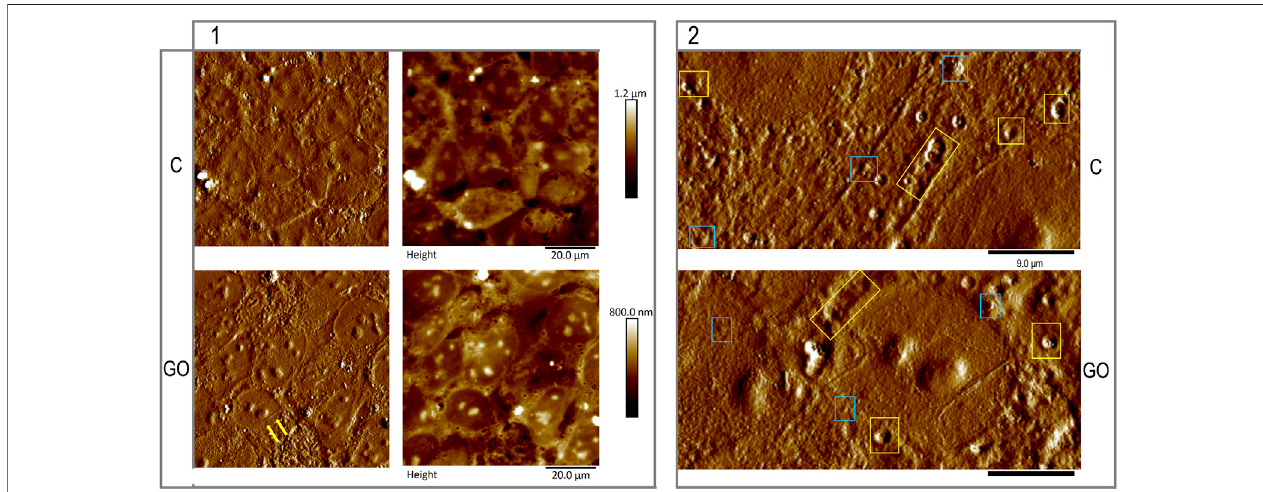
FIGURE 2 | Representative larger areas of the hESCs grown for 2 days on Geltrex base matrix [top row; control (C)] or on the Geltrex/graphene oxide compound substrate [bottom row; (GO)]. In the left panel (1) , we observe that the close cell packing, and colony formation were not affected by the graphene oxide addition to the base matrix. The yellow arrows were placed to show the fi ne edges of a GO nano fl ake the cells are growing on. The surface of the membrane as demonstrated by the AFMrevealedsmallandlargerprotrusionsandpitswithclear,raisedrims.Ontherightpanel (2) ,amagni fi edimageofthecontrol(A)andGeltrex-GO(B)cellculture, possibly showing sites of shedding vesicles are framed in light blue rectangles. The framed in yellow rectangles craters/ pits resemble membrane fused multivesicular bodies forming vesicles for release from the cell membrane.